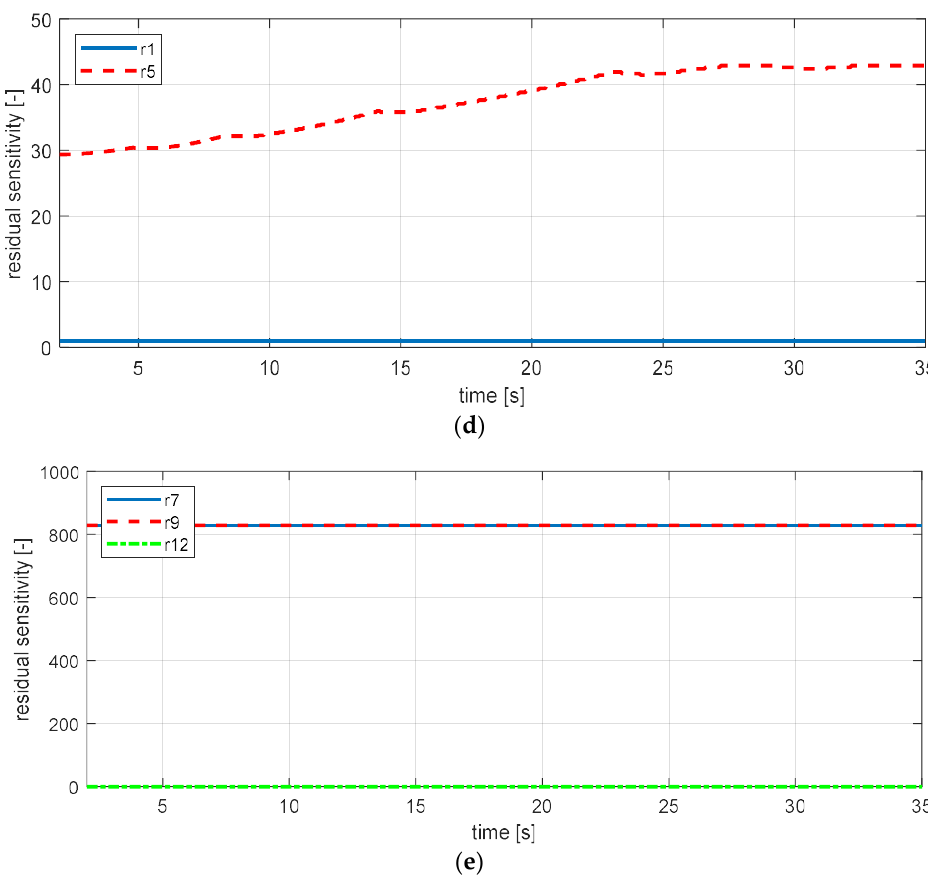
Figure 16. Sensitivity simulation result. ( a ) The sensitivity of yaw rate (residuals 1–4); ( b ) sensitivity of lateral acceleration (residuals 1, 2, 7, 8, 9, 10, 11); ( c ) sensitivity of lateral acceleration (residuals 1, 2, 11); ( d ) sensitivity of wheel angular speed—fl (residuals 1, 5); ( e ) sensitivity of body vertical acceleration—fl (residuals 1, 5). Table 7. Fault detection and isolation table.